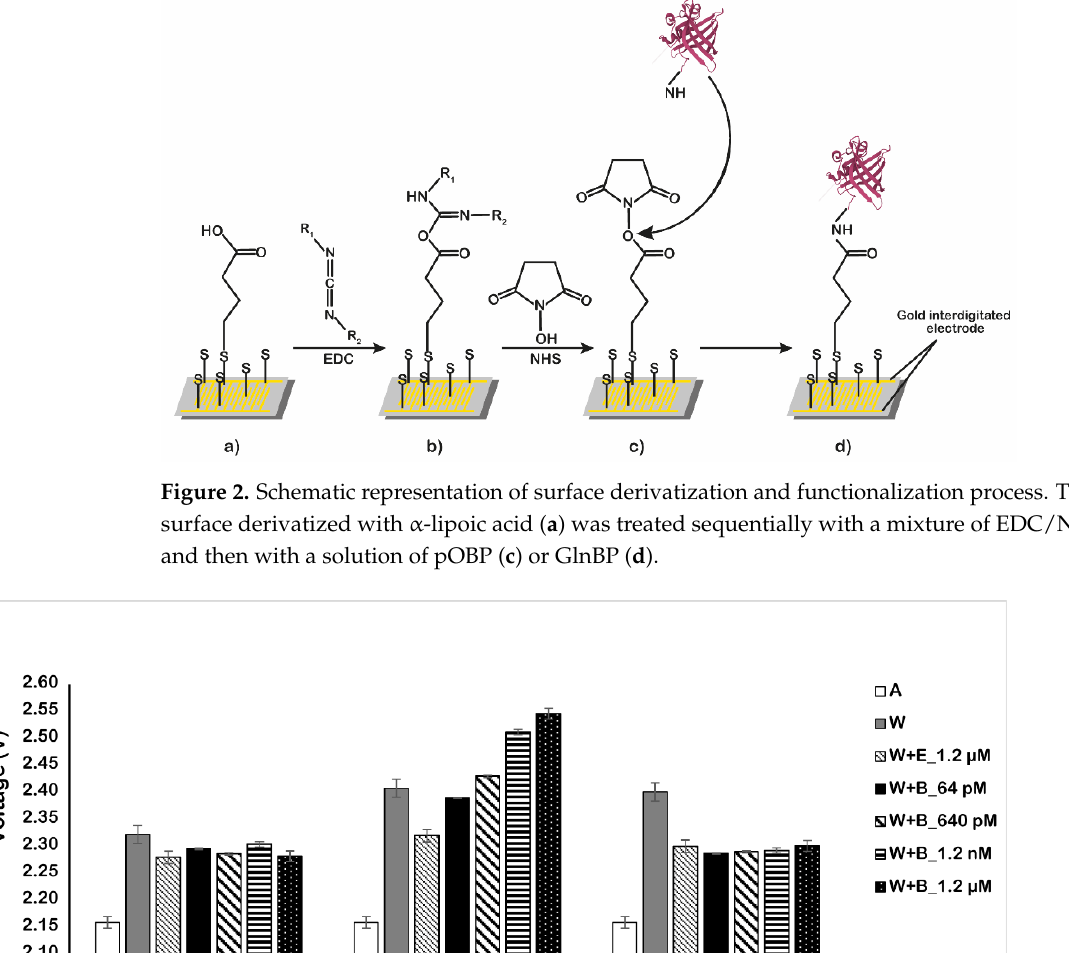
Figure 2. Schematic representation of surface derivatization and functionalization process. The gold surface derivatized with α-lipoic acid ( a ) was treated sequentially with a mixture of EDC/NHS ( b ), and then with a solution of pOBP ( c ) or GlnBP ( d ).